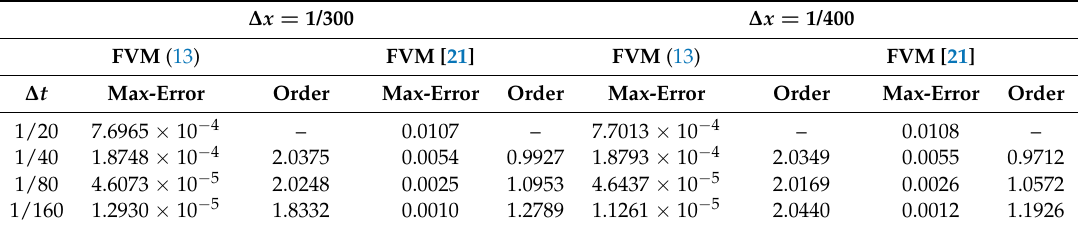
Table 4. Temporal convergence order of new upwind FVM and existing upwind approach of FVM taking k = 0.4, v = 1 in the case of convection dominance.